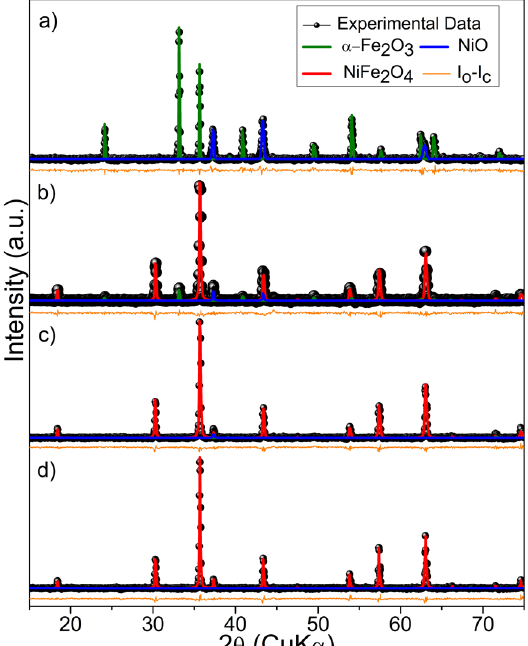
Figure 2. Rietveld analysis of the XRD patterns of (a) the initial mixture of reactants and of the samples submitted to heat treatments at